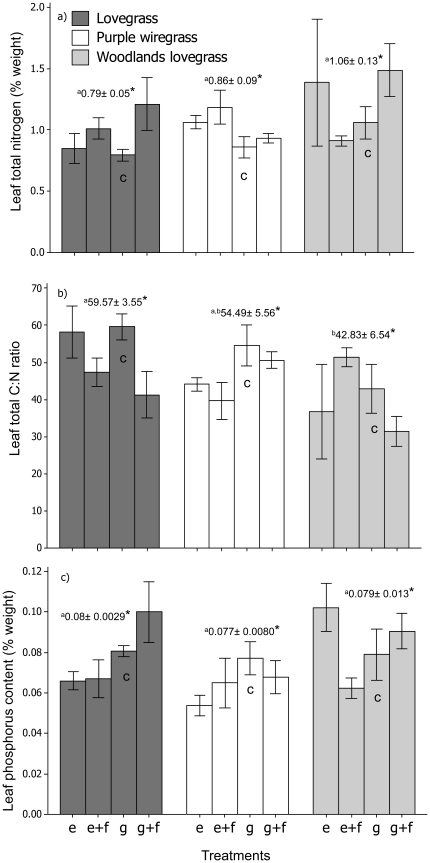
Mean leaf nutrient concentrations (± SE) for each species depending on the grazing and fertilizer treatments.Panel a) shows leaf total nitrogen concentration (% weight), b) leaf carbon to nitrogen ratios and c) leaf phosphorus concentration (% weight). Values shown in each panel are the mean leaf nutrient concentrations (± SE) for each species at the site regardless of treatment. Different letters indicate means are significantly different at p<0.05. C indicates control treatment, grazing/no fertilizer.